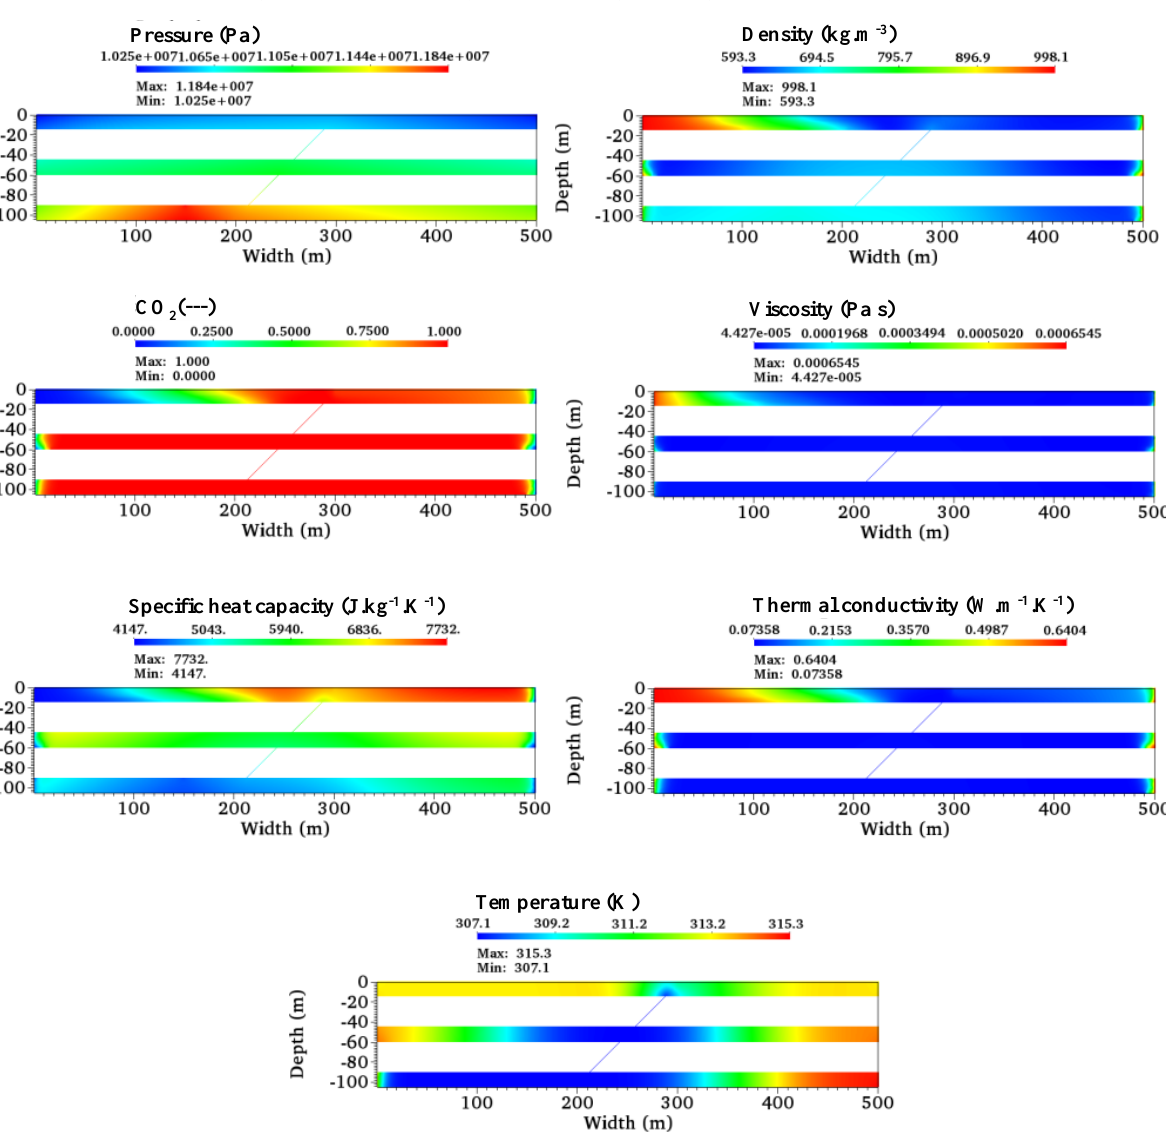
Figure 6. Spatial distribution after 300 days of injection of pressure, density, CO 2 , viscosity, specific heat capacity, thermal conductivity and temperature for thermal gradient = 0.02, injection rate = 0.41319 m 3 /s, α l = 5.0 m and α t = 0.5 m and fracture aperture = 100 µm.